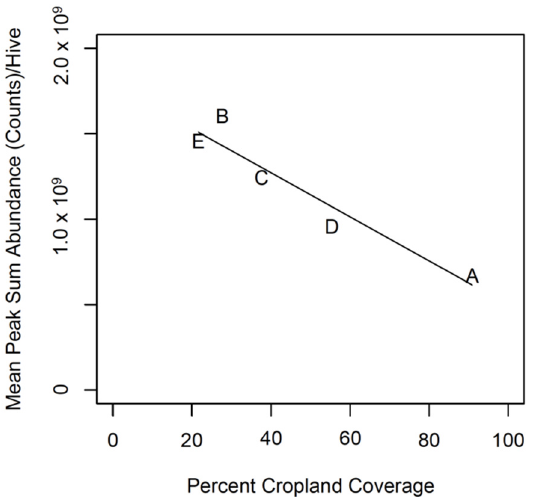
Figure 1. Mean peak sum abundance vs cropland coverage. Mean peak sum abundance was obtained from GC-MS and represents the summed counts of different compounds in the propolis. Cropland coverage for a 3.2-km radius around each apiary (A–E) was obtained from the Cropland Data Layer product of the USDA NASS.